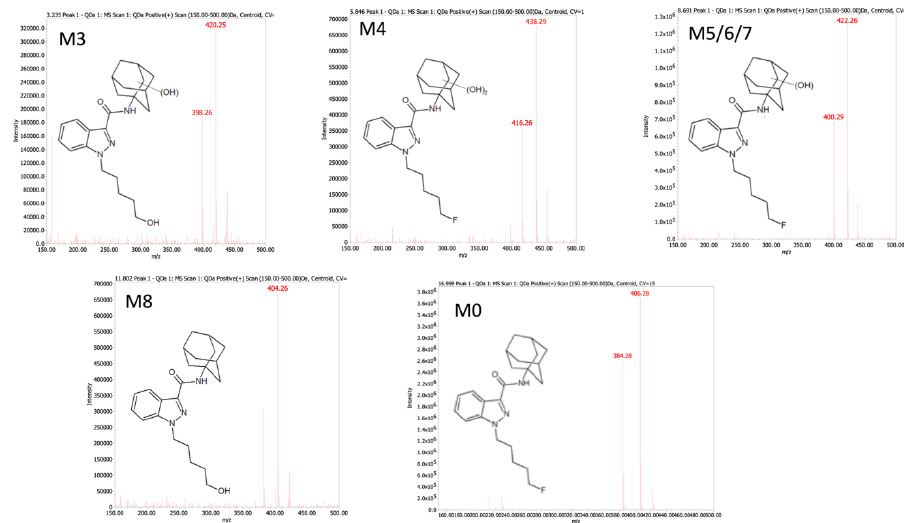
Molecules 2020 , 25 , x FOR PEER REVIEW Figure A2. MS spectra for analyte parent masses corresponding to fluorescence peaks from 5F-APINACA microsomal reaction. We resolved and analyzed metabolites from a 500 µ M 5F-APINACA reaction to correlate fluorescent peaks to parent masses for analytes using a Waters Acquity UPLC-Fluorescence / QDa (single quadrupole) instrument. Major ions reflect parent masses and sodium adducts ( m / z ). Both [MH] + and [M + Na] + values are indicated in the figures.